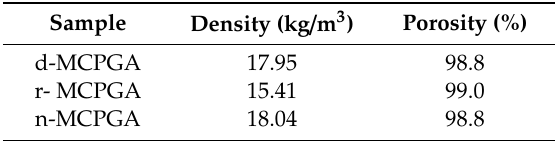
Table 1. Physical properties of MCPGA (d-MCPGA, r-MCPGA,